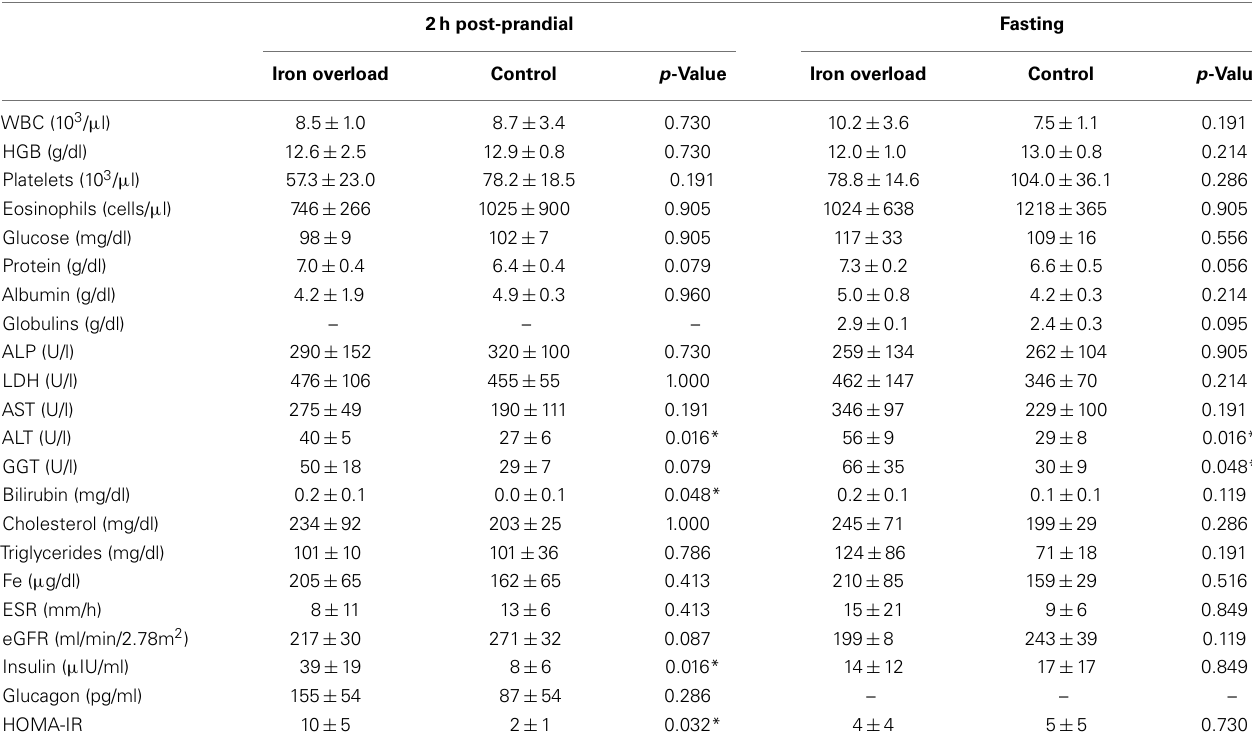
Table 3 | Hematologic and serum biochemistry data of study group.